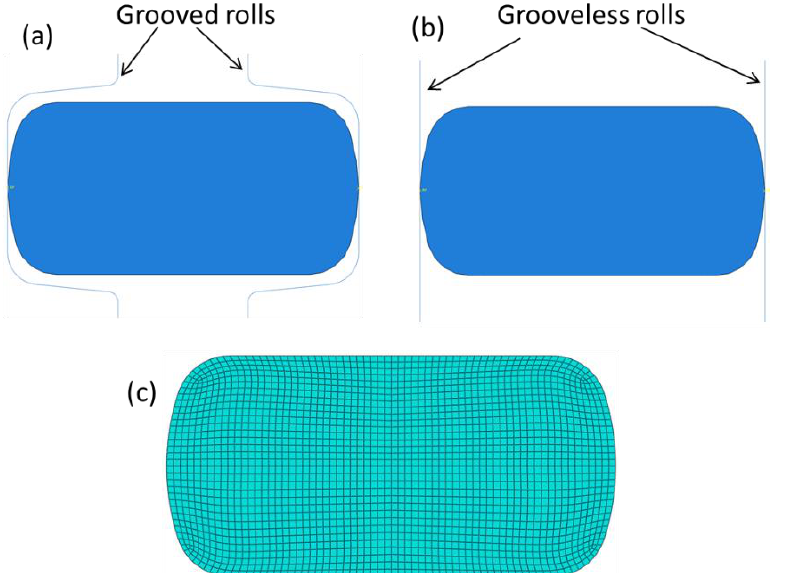
Figure 10. Idealization of the entry strip to stand 14. ( a ) Strip in the grooved roll, ( b ) strip in the grooveless roll, and ( c ) meshed strip for FE simulation.